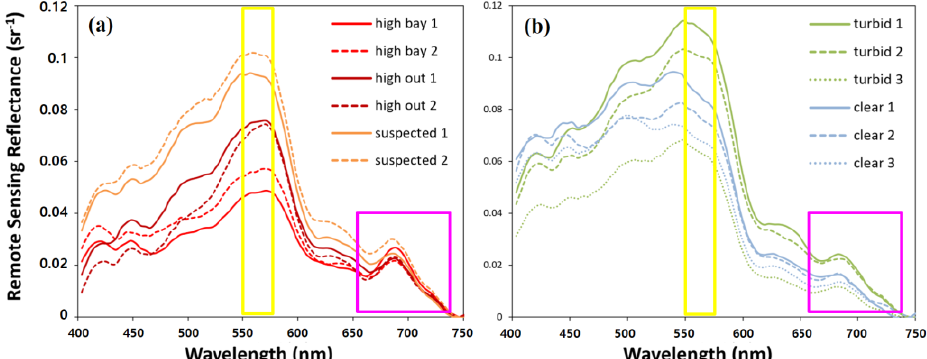
Figure 12 . Comparison of the R rs spectra from (a) red tide-suspected regions and (b) other regions ( i.e. , other turbid water and clear water).